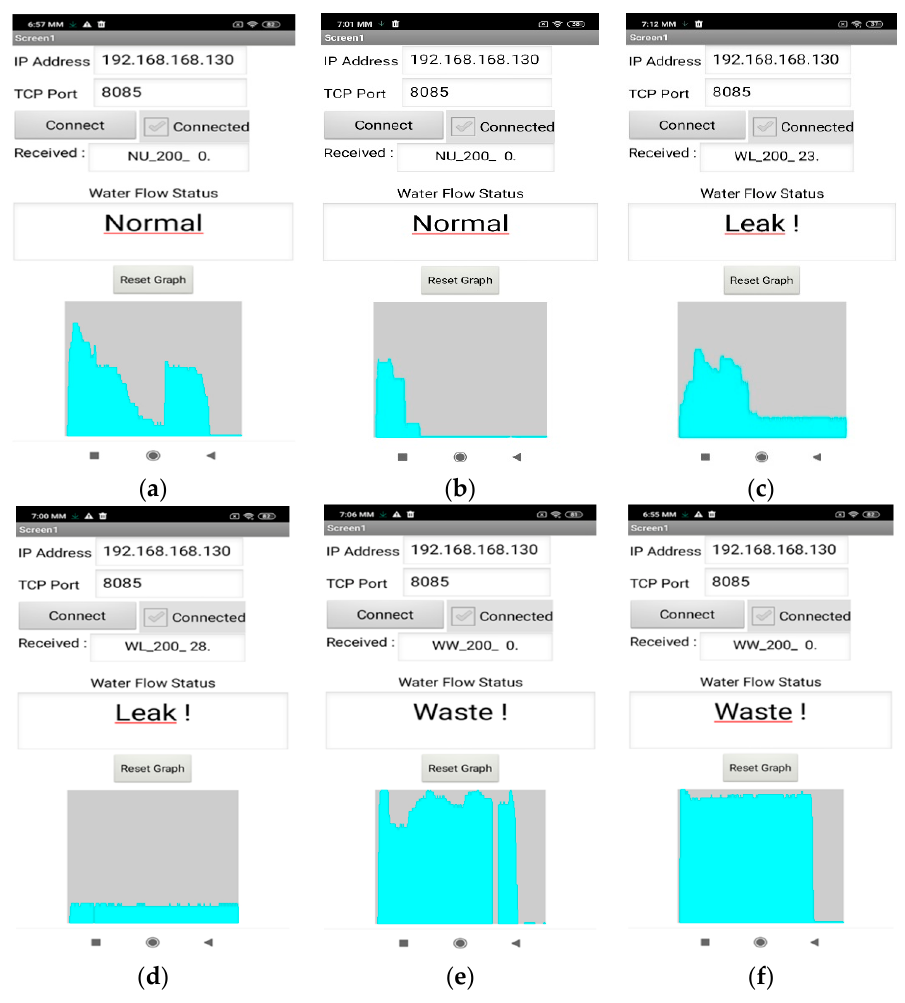
Figure 6. ( a )–( f ) Indicative smart phone screenshots during the in situ testing process, reflecting typical water usage characterization decisions for the categories NU, WL and WW, respectively.